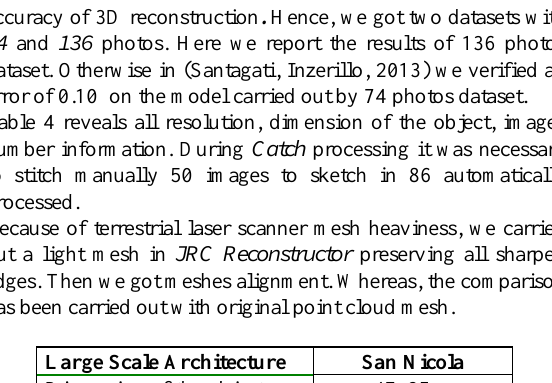
Figure 8: Part of the lateral entrance123D Catch model